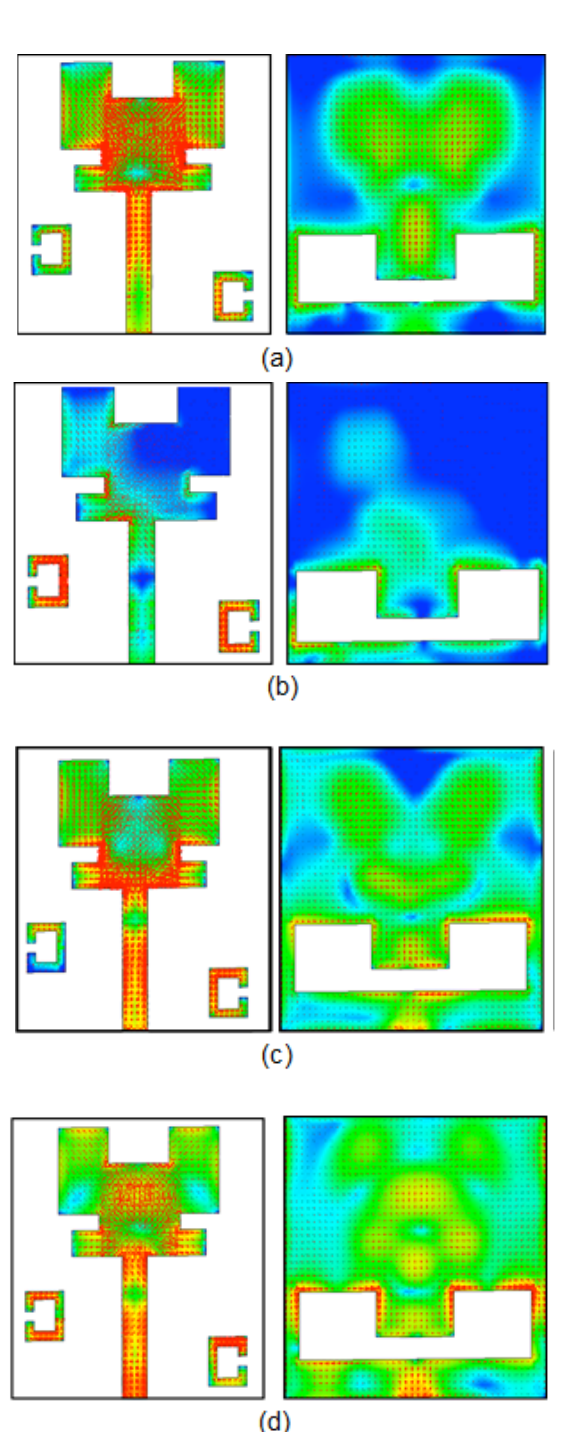
Figure 6. Simulated current distribution of proposed quadruple-band antenna (a) at 4.5 GHz, (b) at 5.5 GHz, (c) at 7.54 GHz and, (d) at 10